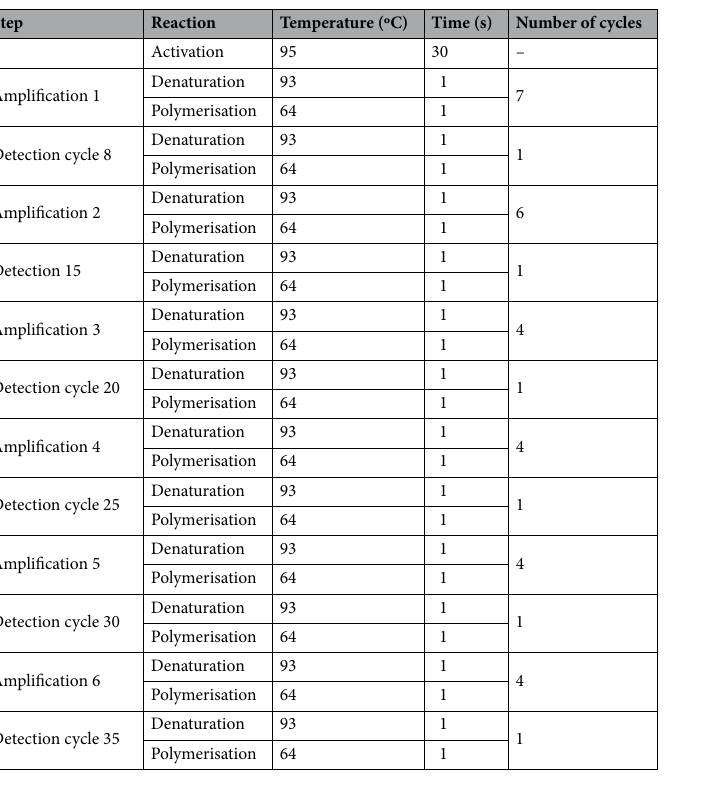
Table 1. Protocol for multiple cycle fluorescence